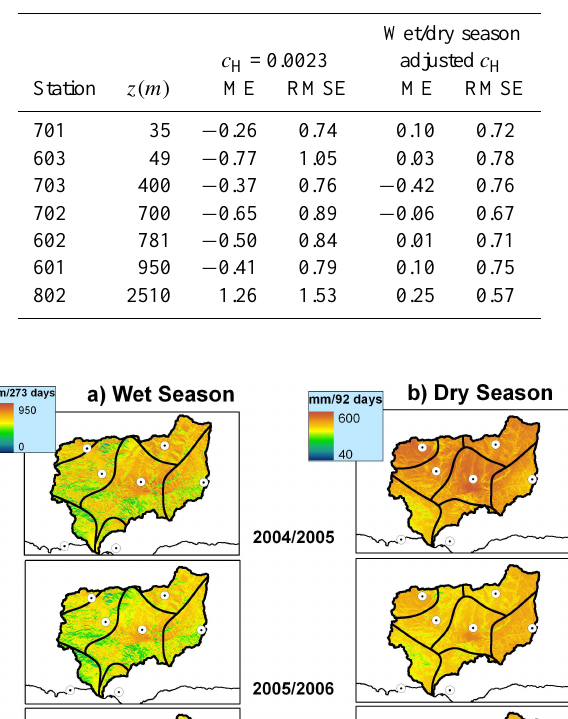
Table 6. Mean error (ME – mmday − 1 ) and root mean squared error (RMSE – mmday − 1 ) for the validation period (1 September 2008– 2 July 2010) with the constant 0.0023 coefficient and the c H ad-